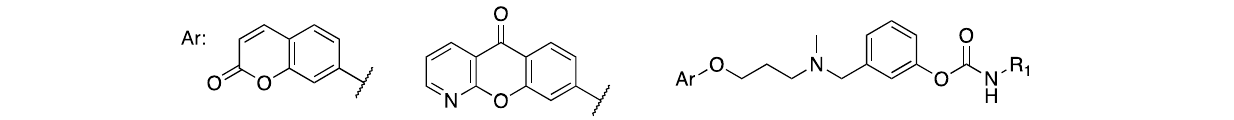
Cells 2022 , 11 , x FOR PEER REVIEW